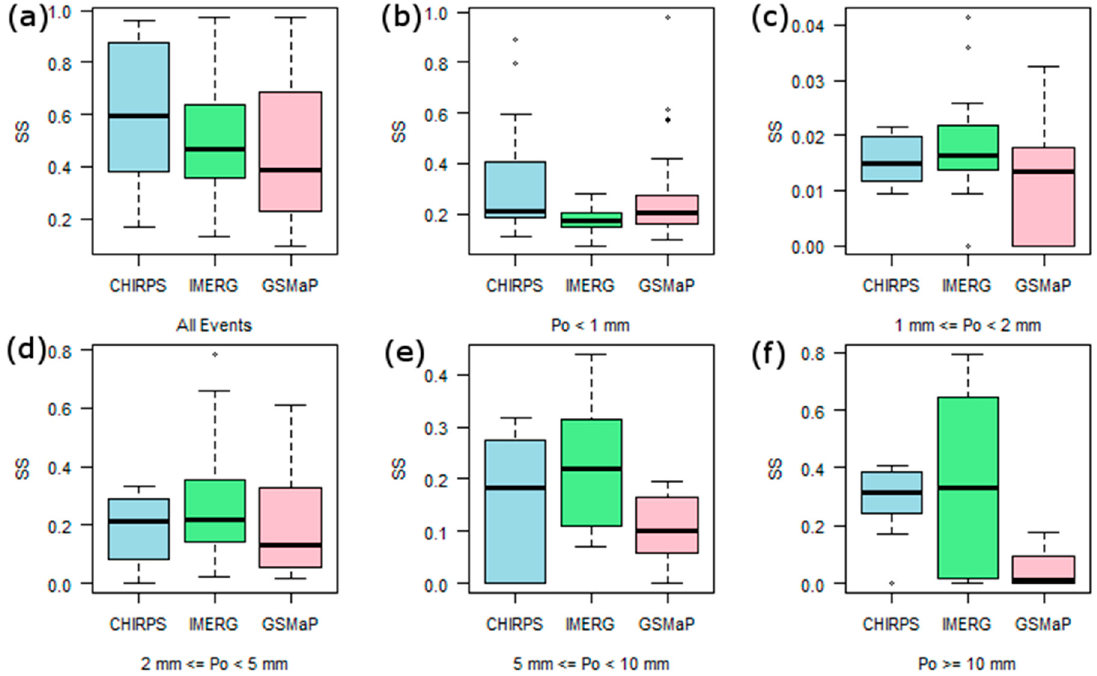
Figure 8. Box plots of Skill Score (SS) of the three satellite-based datasets in the estimation of rainfall amount for ( a ) all events, and ( b – f ) different intensity ranges as shown in the corresponding plot.